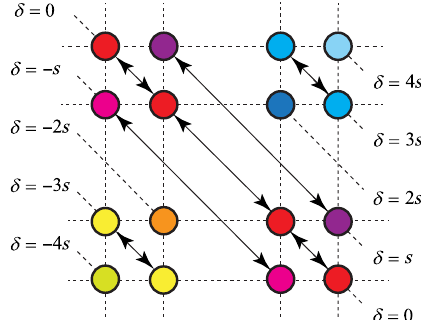
FIG. 4. Diagonal and off-diagonal Crooks relations. Because of energy conservation in combination with the particular class of initial states, it turns out that the dynamics of the energy reservoir decouples along the modes of coherence [35]. One can think of these as the collection of diagonals (main and off diagonals) of the density operator represented in an energy eigenbasis. Because of the decoupling, it follows that the quantum fluctuation relation (2) can be separated into individual Crooks relations for each mode of coherence. As an example, suppose that the spectrum of the reservoir includes the energy levels E 1 ¼ 0 , E 2 ¼ s , E 3 ¼ 3 s , E 4 ¼ 4 s for some s > 0 . The dynamics on the main diagonal, δ ¼ 0 , satisfies the relation in Eq. (11). Each of the diagonals with offsets δ ¼ (cid:4) s , (cid:4) 2 s , (cid:4) 3 s , (cid:4) 4 s satisfies a Crooks relation as in Eq. (12). For a more concrete example of the decoupling, see Fig.